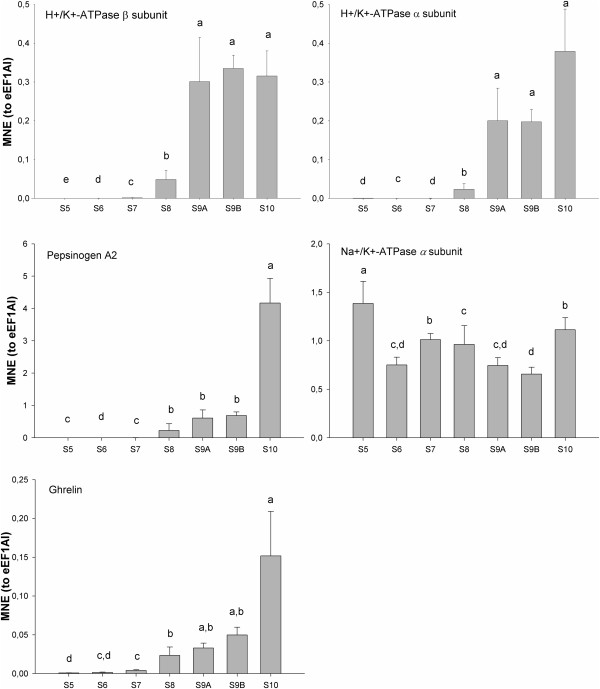
Mean normalized expression patterns of the indicated mRNA transcripts of individual larvae (stage 5–10). Results for pepsinogen A2 precursor, gastric H+/K+-ATPase subunit α and β, Na+/K+-ATPase subunit α and ghrelin mRNA transcripts are shown as mean ± SEM of the normalized expression (using the reference gene eEF1A1). Mean values with different letters are significantly different (One Way ANOVA, p < 0.05).